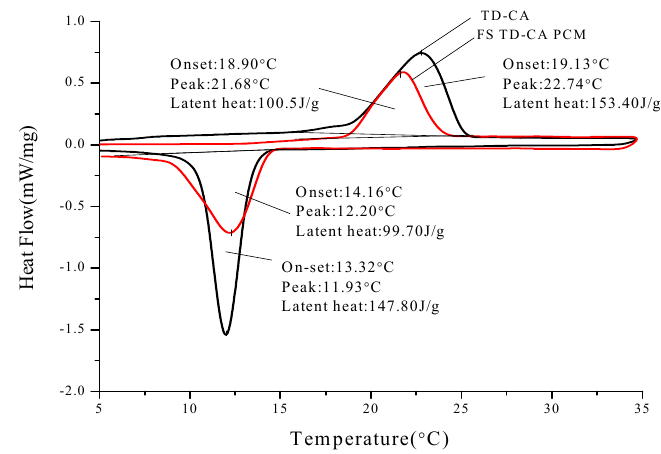
Figure 8. DSC curves of TD-CA eutectic mixture and FS TD-CA PCM. Their onset temperatures, peak temperatures and latent heat are present.